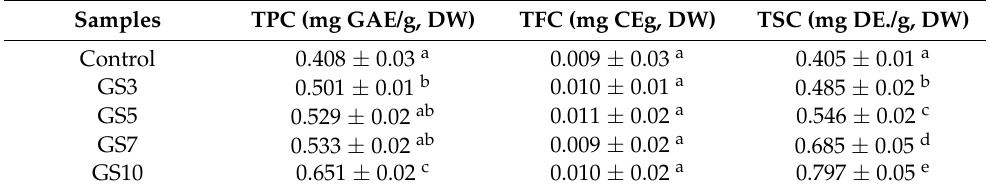
Table 2. Total phenolic content (TPC), total flavonoid content (TFC), and total saponin content (TSC) of the